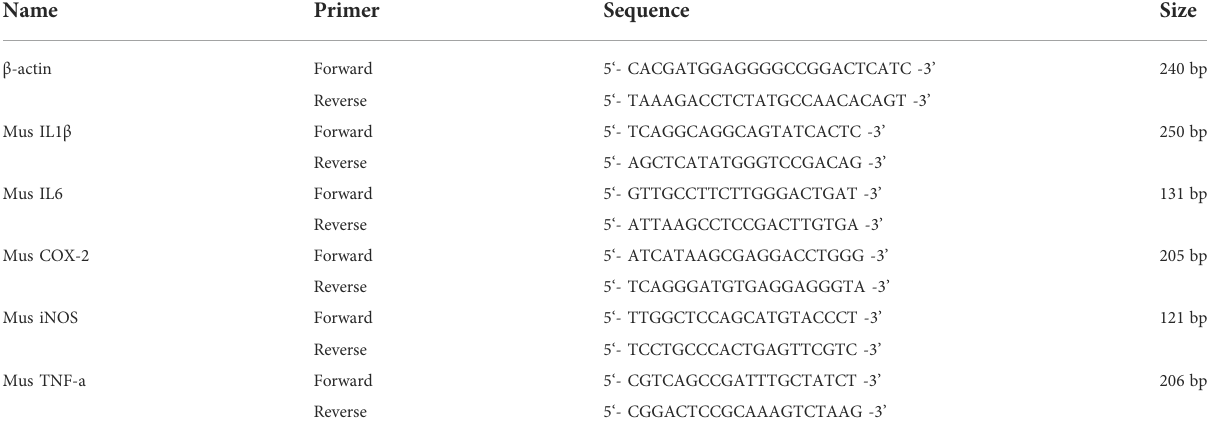
TABLE 1 Primer sequences for RT-q